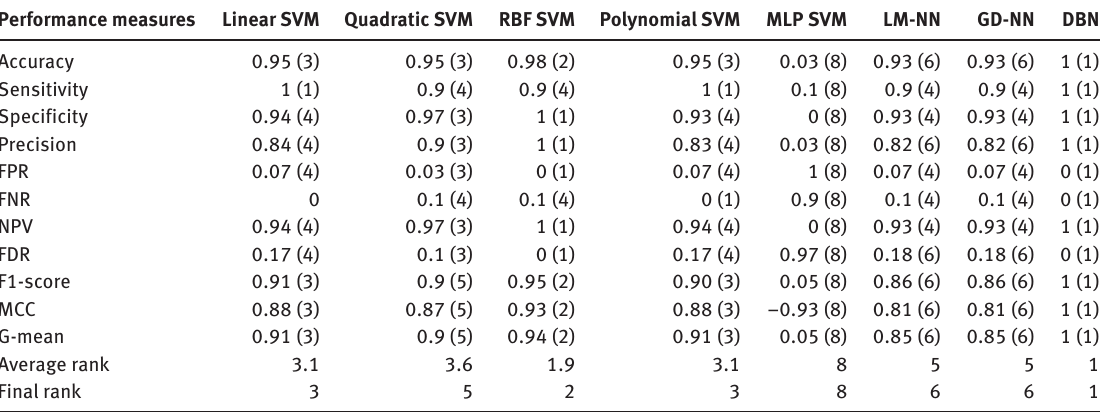
Table 2: Performance Analysis of Proposed and Conventional Fault Signal Recognition in Power Distribution System for Transient Signal.